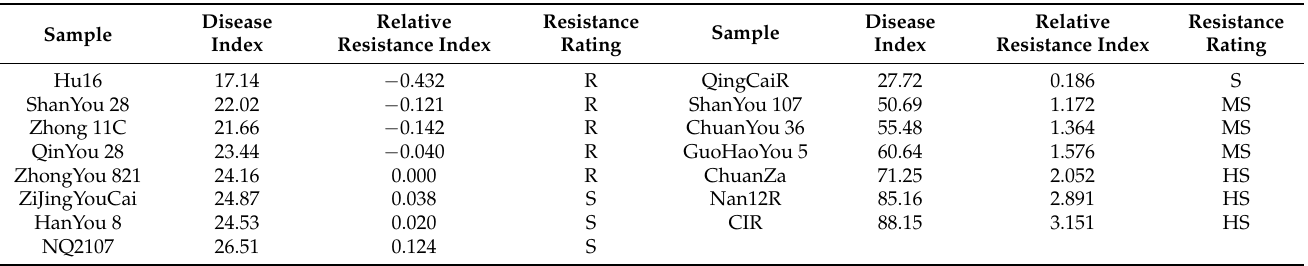
Table 3. The information of disease rating of Sclerotinia sclerotiorum